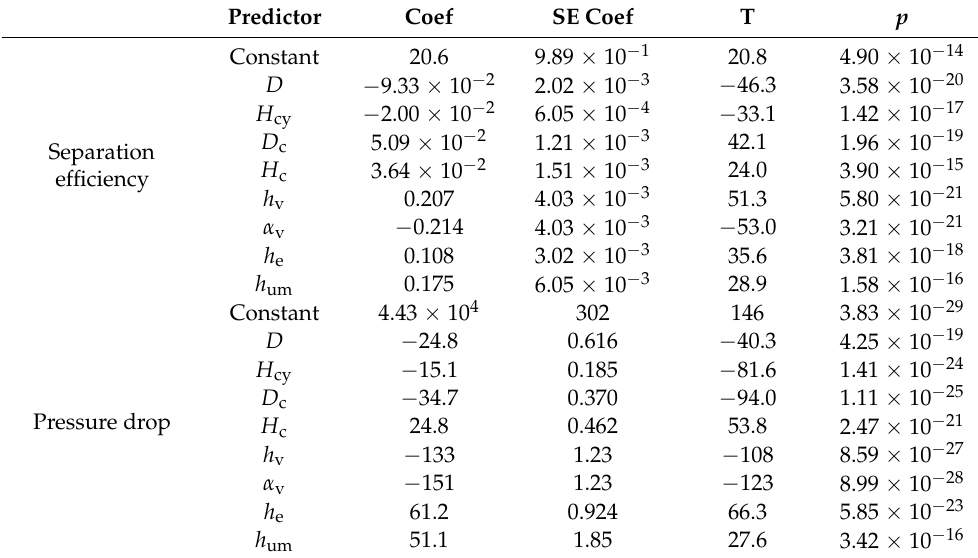
Table 8. Regression analysis for factors on separation efficiency and pressure drop. Predictor